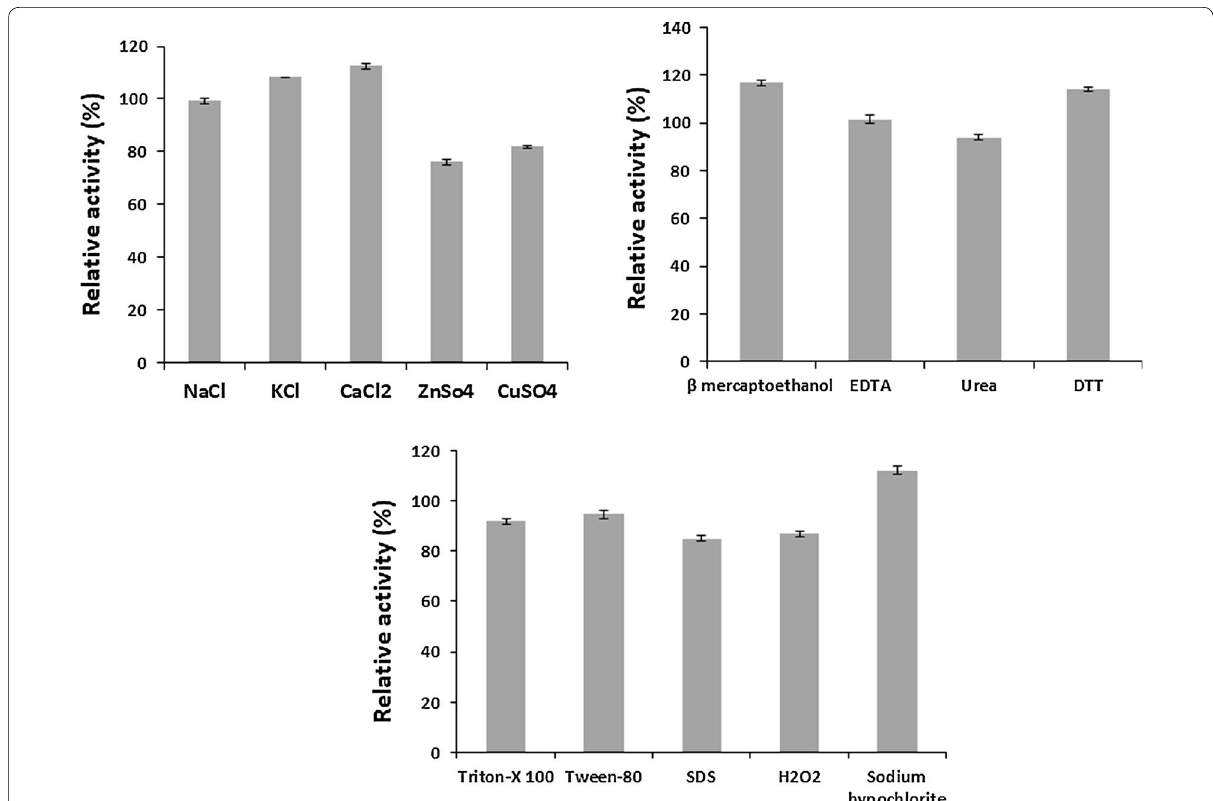
Fig. 8 Effect of metal ions, inhibitors, surfactants, detergents and oxidizing agents on endoglucanase activity. Endoglucanase activity was determined at 70 °C at pH 7.0 in the presence of various metal ions, inhibitors, surfactants, detergents and oxidizing agents. After a period of 1 h pre-incubation, endoglucanase activity was assayed. The enzyme activity without pre-incubation with metal ions, inhibitors, surfactants, detergents and oxidizing agents was taken as 100%. Mean standard deviation for all the values is ±